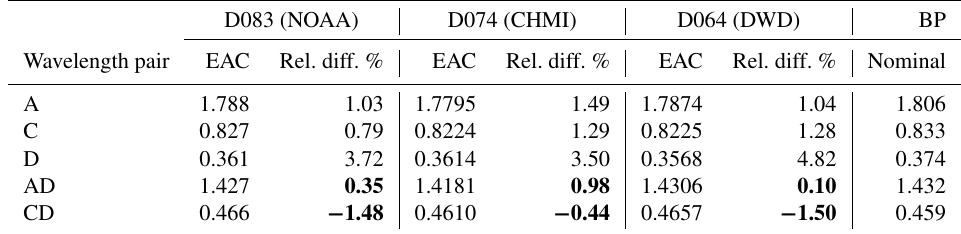
Table 4. Effective absorption coefficients (EACs) calculated with IUP cross sections and relative difference to EACs obtained with “old” Bass–Paur cross sections and nominal slit functions. Relative TOC-differences in the most relevant observation modes AD and CD are marked in bold. D083